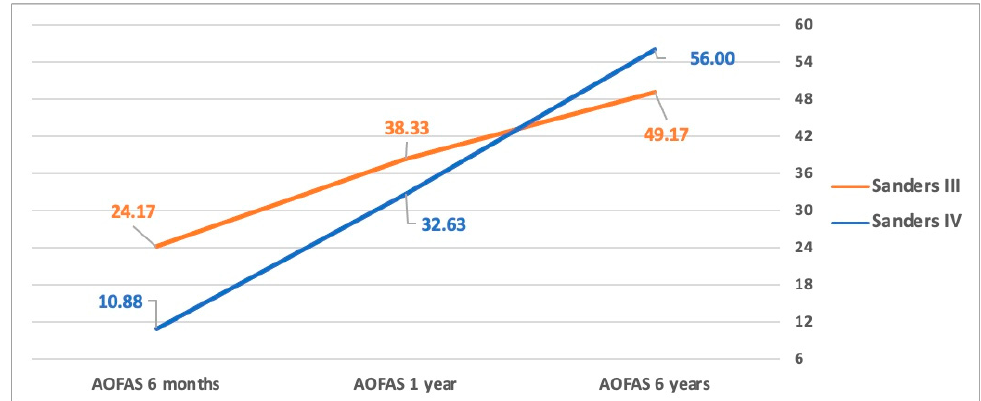
Figure 1. AOFAS score between Sanders types III and IV. The AOFAS score at six months follow-up showed better outcomes in patients affected by Sanders type III fractures ( p = 0.03). This difference gradually decreases at one-year follow-up with the tendency to inversion between the two groups, but without statistical significance.